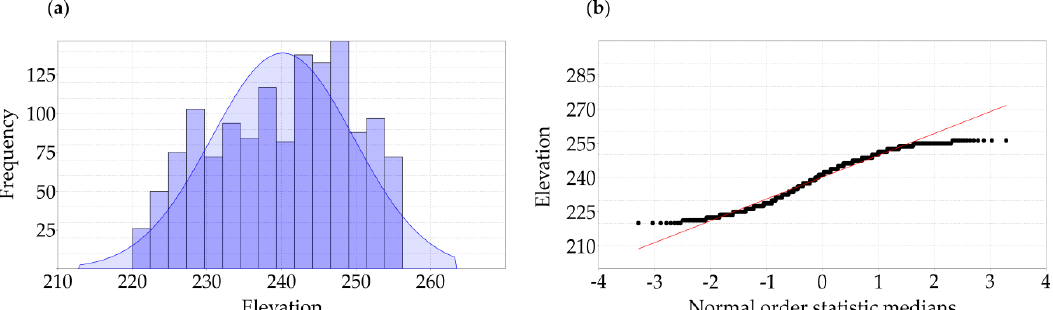
Figure 5. Distribution of the studied elevation in the Krzemionki mining area and its surroundings: ( a ) histogram; ( b ) QQ plot.